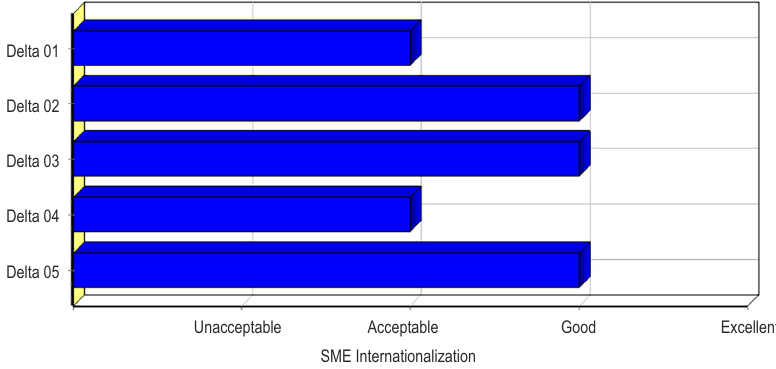
Figure 10. Deltas’ overall evaluation levels